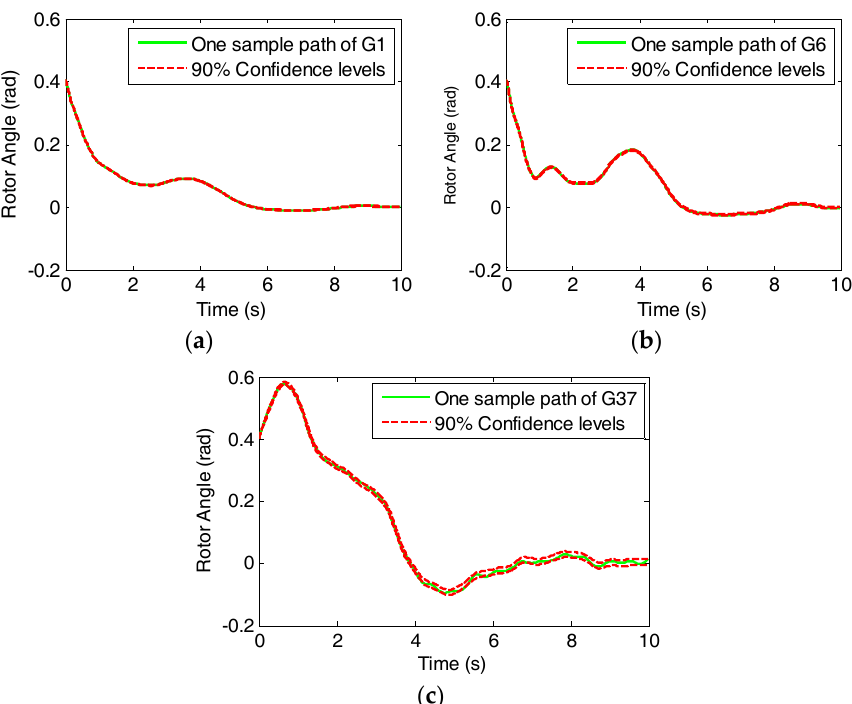
Figure 8. Numerical results of the 145-bus test system: ( a ) the rotor angle responses of G1 with its upper and lower bounds; ( b ) the rotor angle responses of G6 with its upper and lower bounds; ( c ) the rotor angle responses of G37 with its upper and lower bounds.